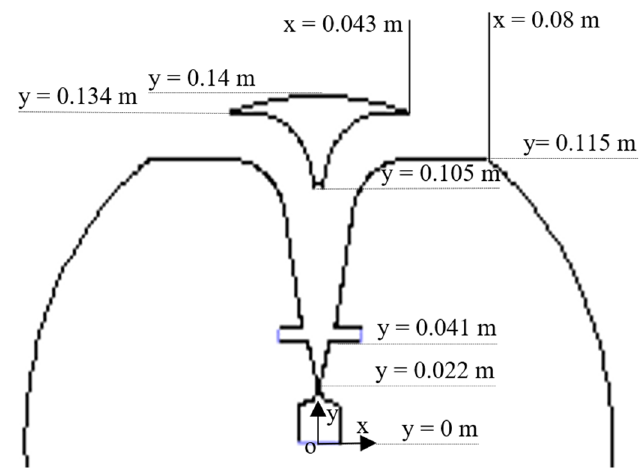
Figure 6. Geometric model of internal and external flow fields.